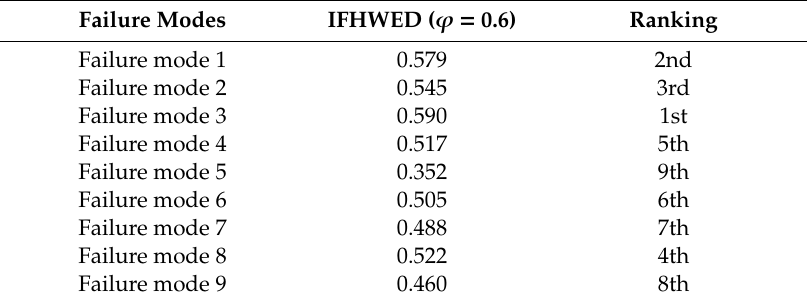
Table 15. Ranking of failure